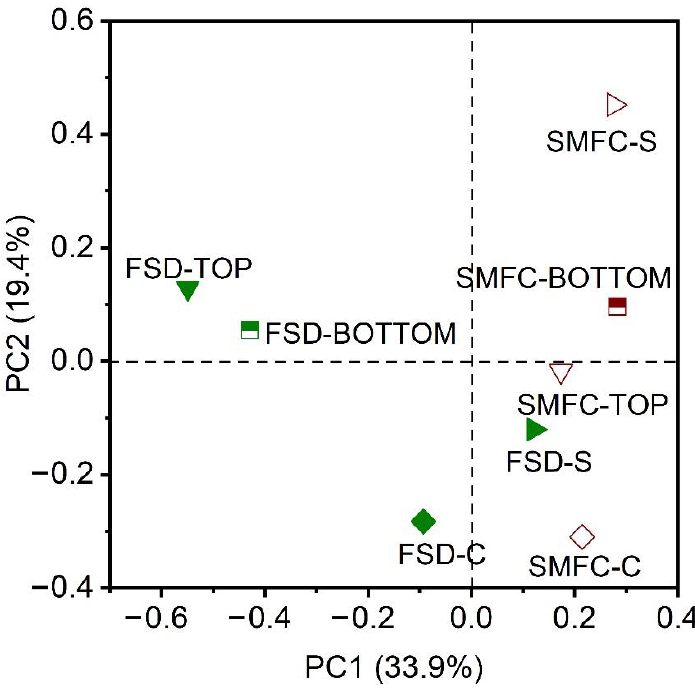
Figure 4. Principal coordinate analysis (PCoA) of different samples based on Bray – Curtis distance.